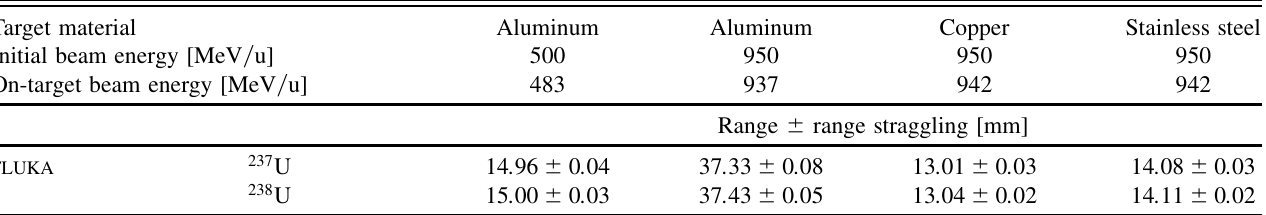
TABLE III. Range and range straggling of the 237 U fragments and the 238 U primary ions in aluminum, copper, and stainless-steel target calculated by FLUKA2011.2.3 . The initial energy of the primary ions was 500 and 950 MeV = u . Energy losses of the primary beam in vacuum window, air gap, and SEETRAM and 1 (cid:3) -momentum spread of the beam dp=p ¼ 5 (cid:1) 10 (cid:2) 4 were taken into account in the calculations. The relative standard uncertainty of the presented data is below